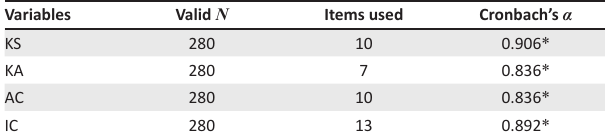
TABLE 1: Reliability